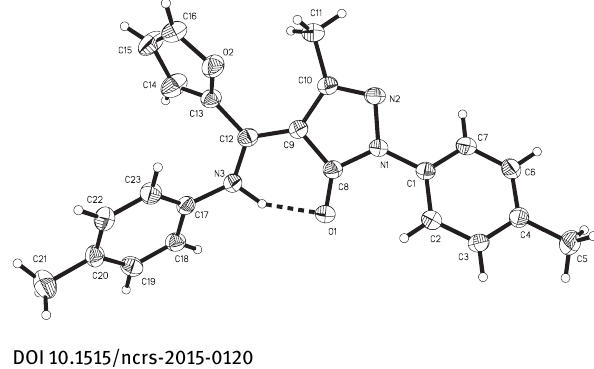
Table 1: Data collection and handling.